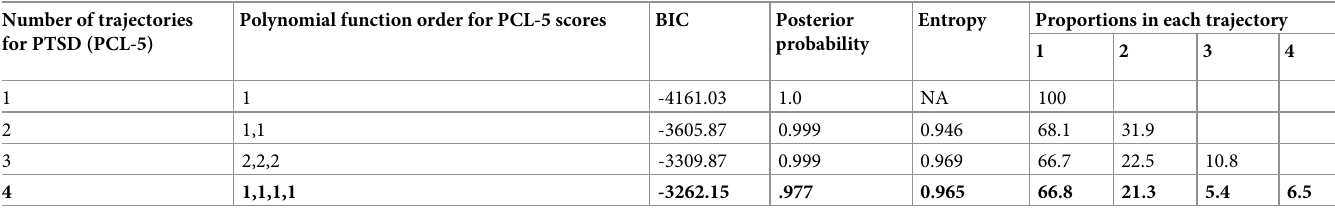
Note: NA = Not applicable.